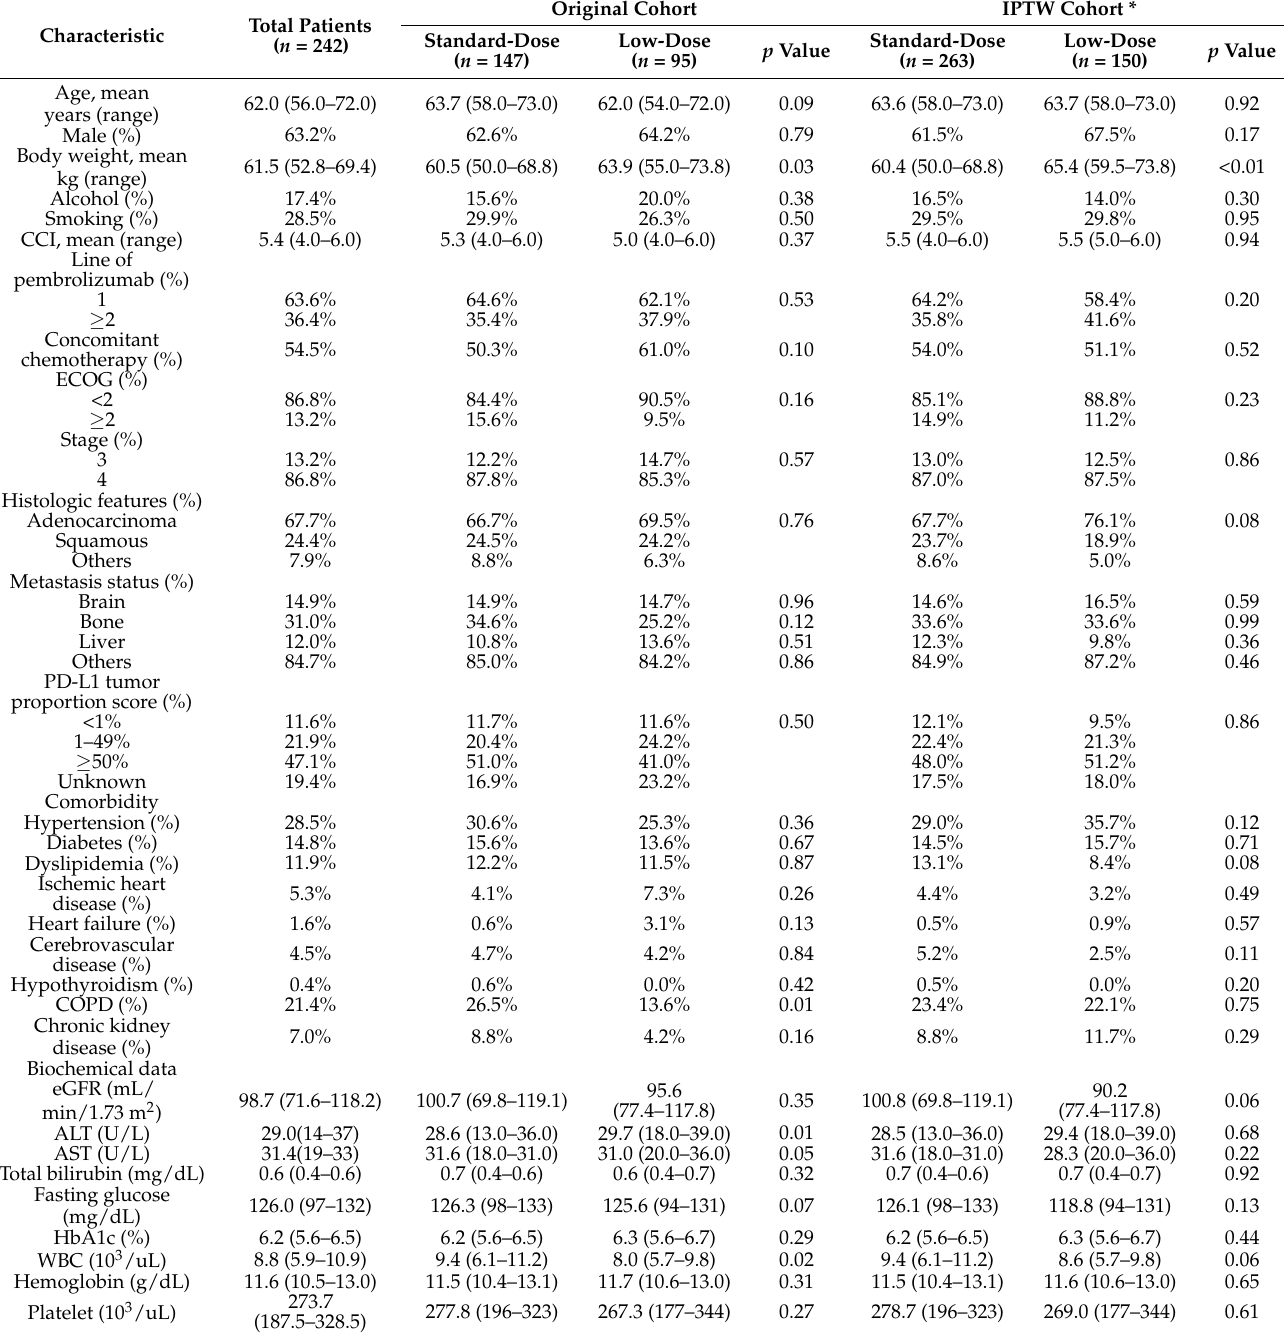
Table 1. Baseline